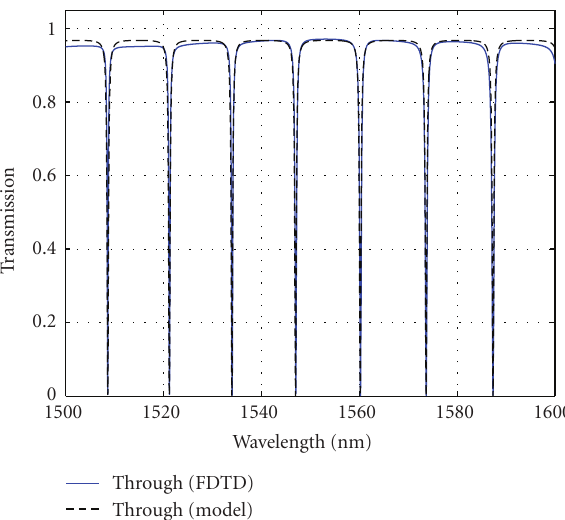
Figure 3: Comparisons between the spectral response of the Through Path (Port 1 (cid:3) to Port 3 (cid:3) ) of the passive 1 × 2 PSE, calculated via 2D-FDTD and by means of the s -matrix model.